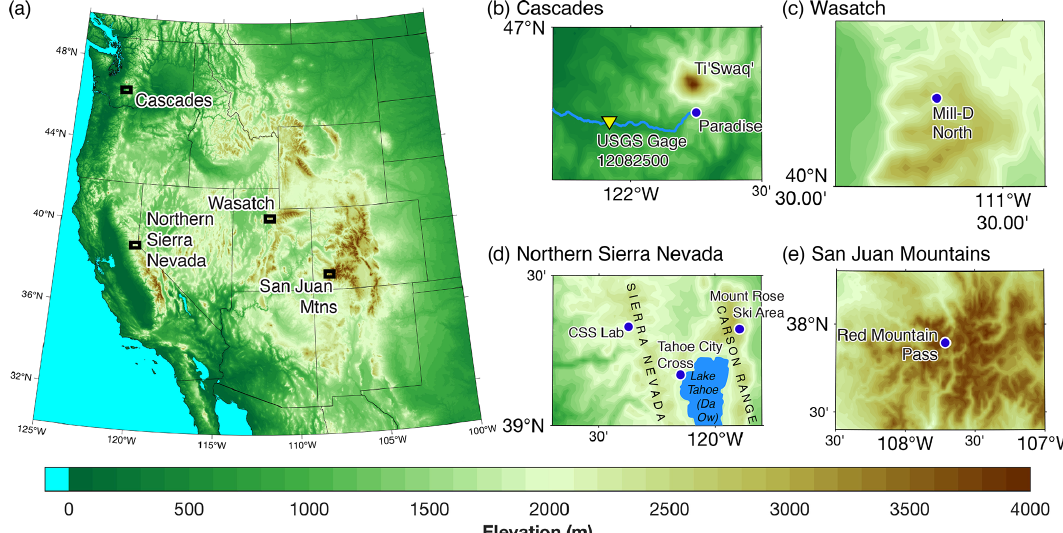
Figure 1. (a) Digital elevation map of western United States topography (in meters) from ETOPO (Amante and Eakins, 2009) showing focus study areas: (b) the Cascade Mountains, (c) the Wasatch Mountains, (d) the northern Sierra Nevada, and (e) the San Juan Mountains. SNOTEL stations are shown by blue dots. The yellow triangle indicates the US Geological Survey Gage 12082500 on the Nisqually River. Table 1. Metadata for western United States SNOwpack TELemetry (SNOTEL) stations used to generate the phase diagrams. Station name Elevation Lat Long Start date Snow climate (m) ( ◦